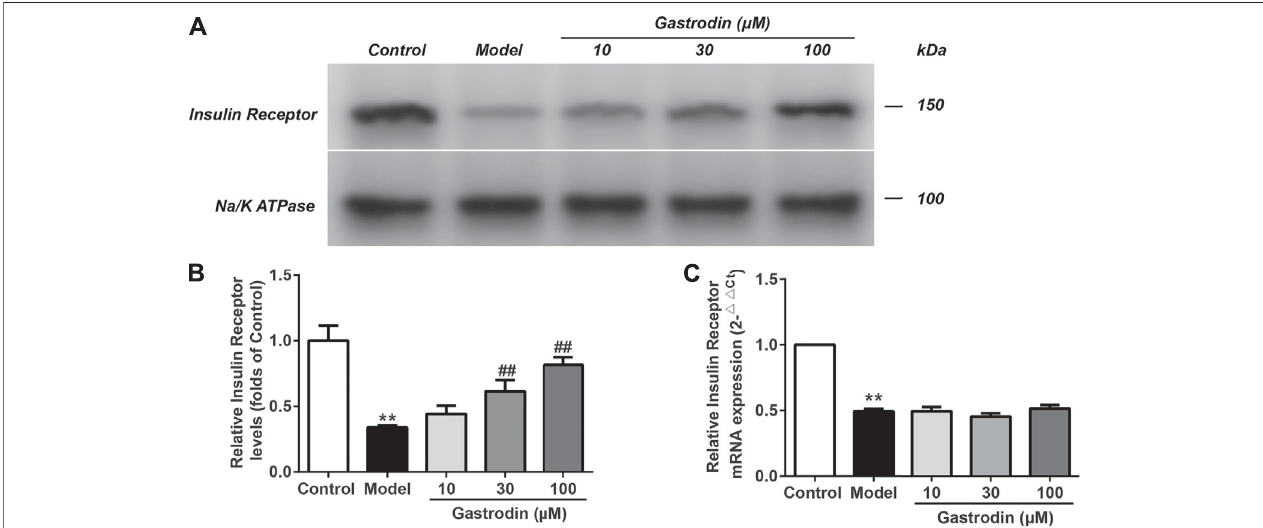
FIGURE 9 | The levels of insulin receptor expressions and mRNA expressions of insulin receptor in HepG2 from different groups. The representative bands were shown in (A) .Thelevelsofinsulinreceptor (B) werenormalizedtocontrol.ThemRNAlevelsofinsulinreceptor (C) wasnormalized tocontrol.Theresultswerepresented as mean ± SD ( n (cid:1) 3). ** p < 0.01, vs. control group, ## p < 0.01, vs. Model